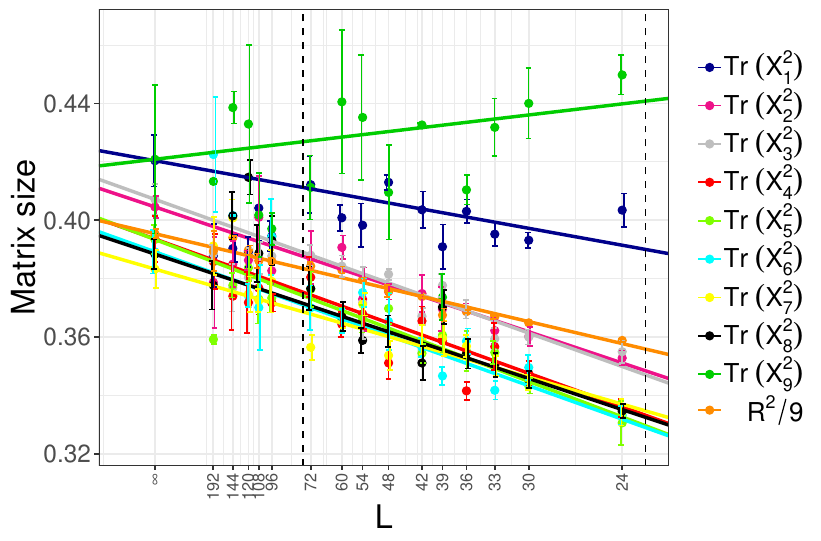
Figure 6 . Sizes of the nine matrices and their average as a function of L , plotted with 1 /L scaling, for N = 16 , T = 0 . 3 , µ = 0 . 5 . We observe agreement in the continuum limit, showing that the observed symmetry breaking is a lattice artifact. The extrapolation is linear using data points within the dashed lines. L > 72 is omitted due to low statistics and a likely underestimation of the error